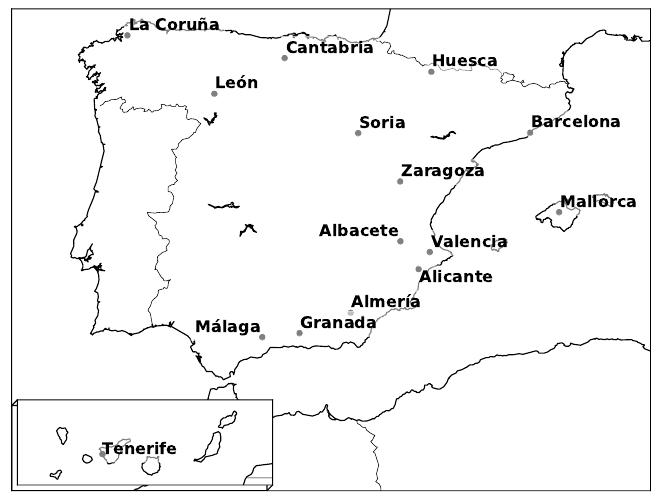
Figure 5. Location of the hourly rainfall gauges used to perform the simulation of the rainfall by the Neyman–Scott rectangular pulse model